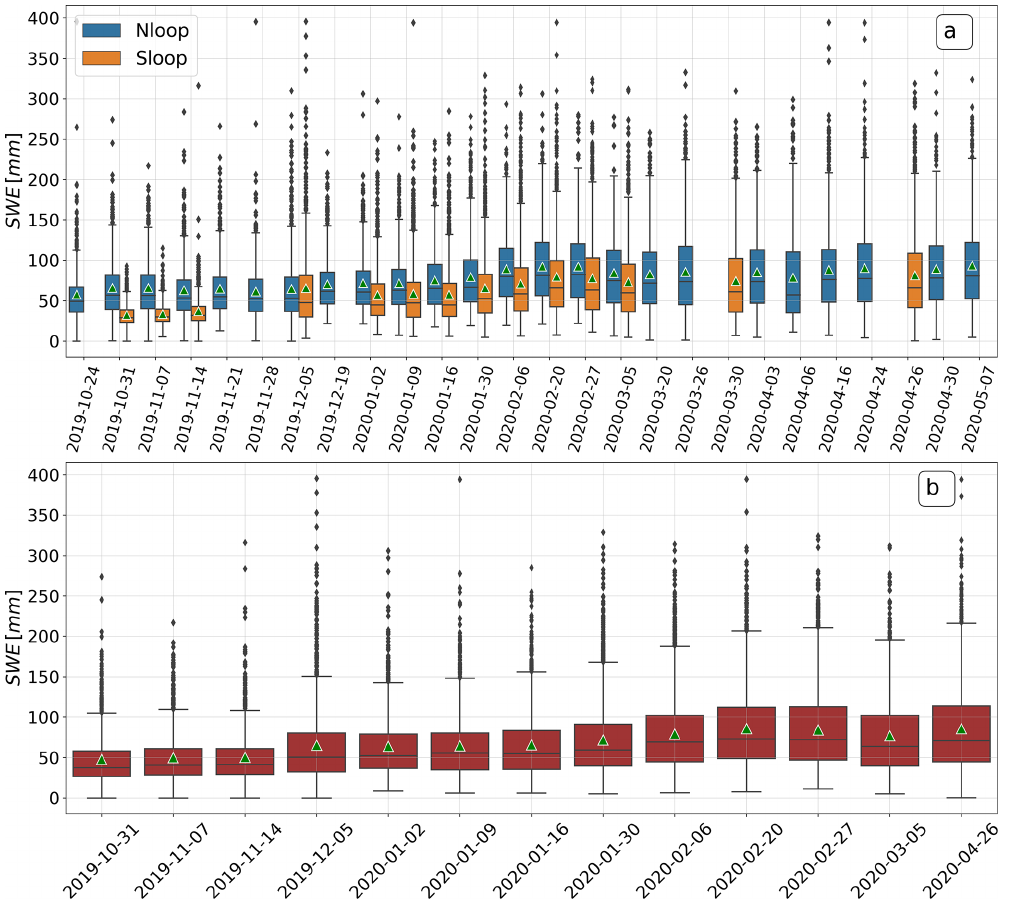
Figure 8. (a) Box-and-whisker plots for SWE estimates along the northern (“Nloop”) and southern (“Sloop”) transect. (b) Box-and-whisker plots for averages of the northern and southern transect loops. Horizontal lines show the median, green triangles the average, the boxes show the interquartile ranges (IQR) (25%–75%), and the whiskers represent 1.5 times the upper and lower values of the IQR. The dots represent outliers that are beyond 1.5 times the IQR. Note the different dates between (a) and (b) as data where only data for one loop were available were discarded for computation of (b) . The exception is 24 and 26 April 2020 as the temporal distance was so close that these were averaged,